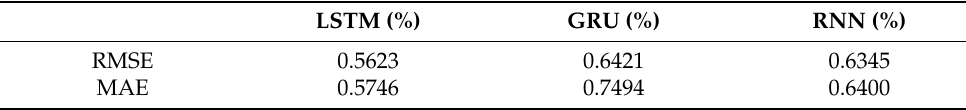
Table 2. The RMSE and MAE results from the testing of battery